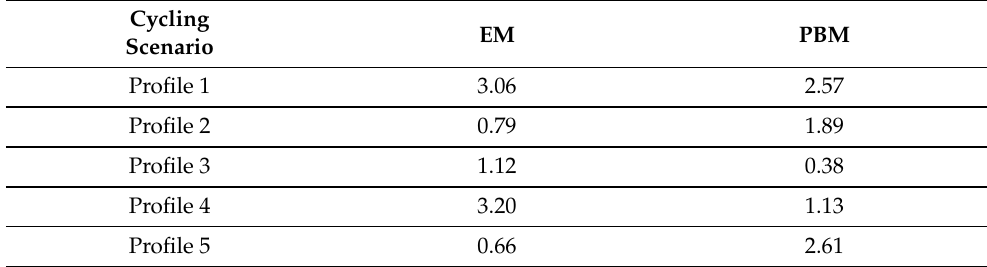
Table 4. Mean absolute error for capacity fade in cycling aging with all models (expressed in %).